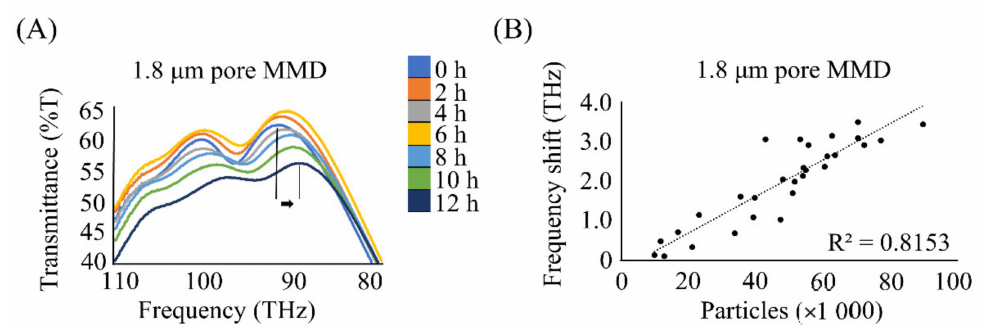
Figure 4. ( A ) Spectral changes over time for the 1.8 µ m MMD, showing a shift of − 3.15 THz after collecting aerosol particles for 12 h. ( B ) The regression line of particle number vs. frequency shift for particles captured by the 1.8 µ m MMD (R 2 ,